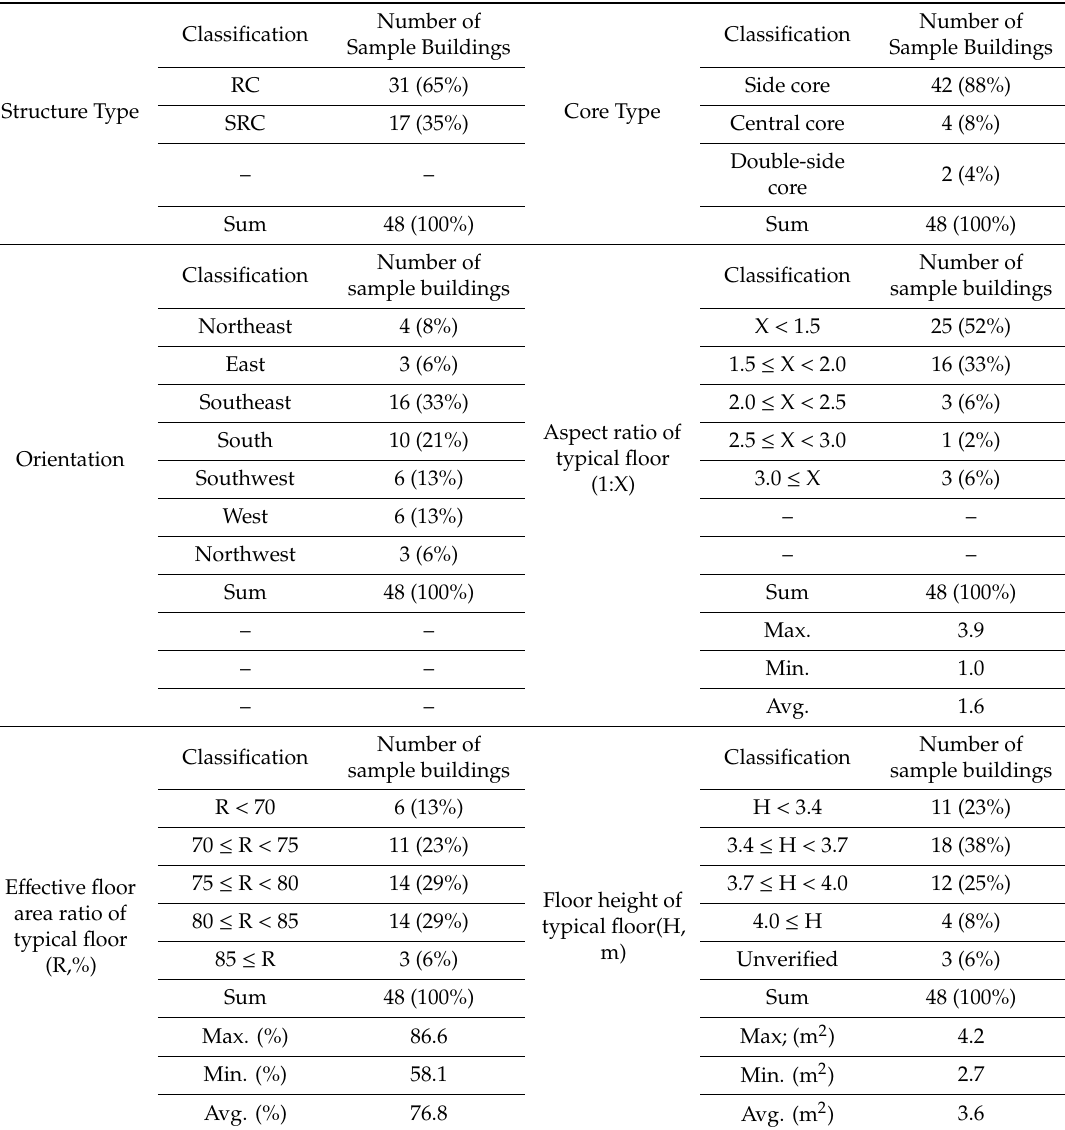
Table 6. Construction